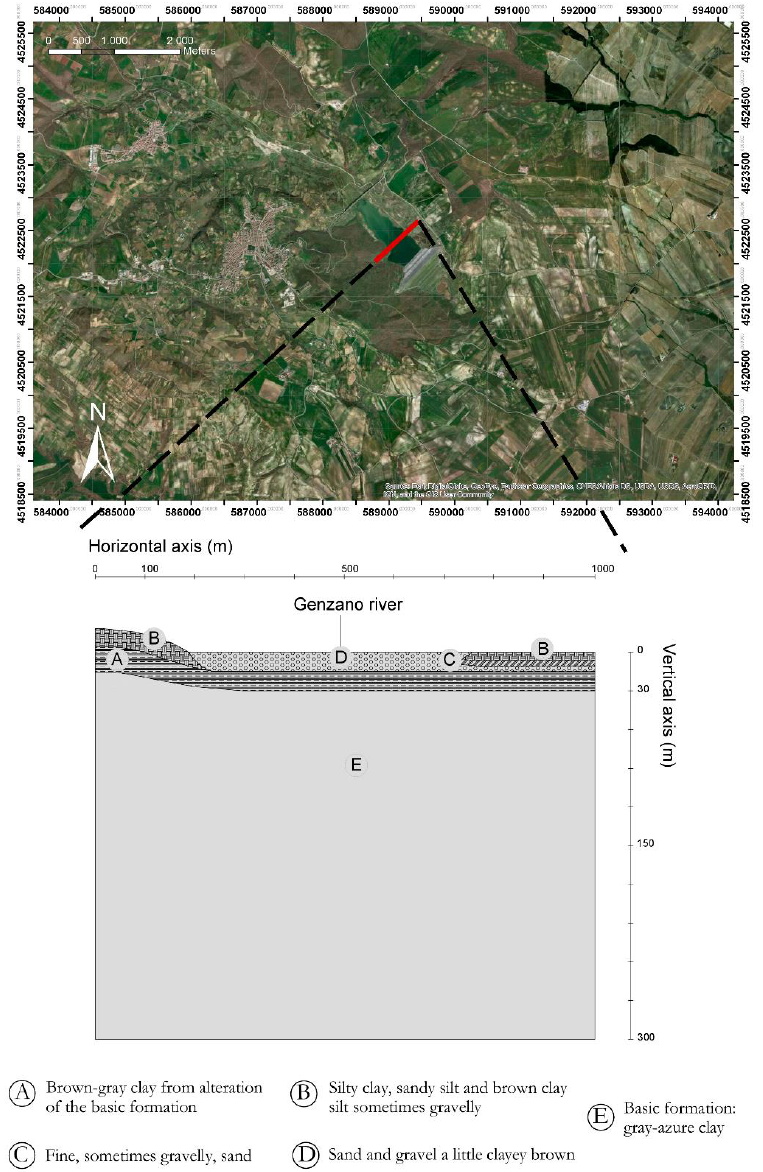
Figure 17. Geognostic section on the axis of the dam.